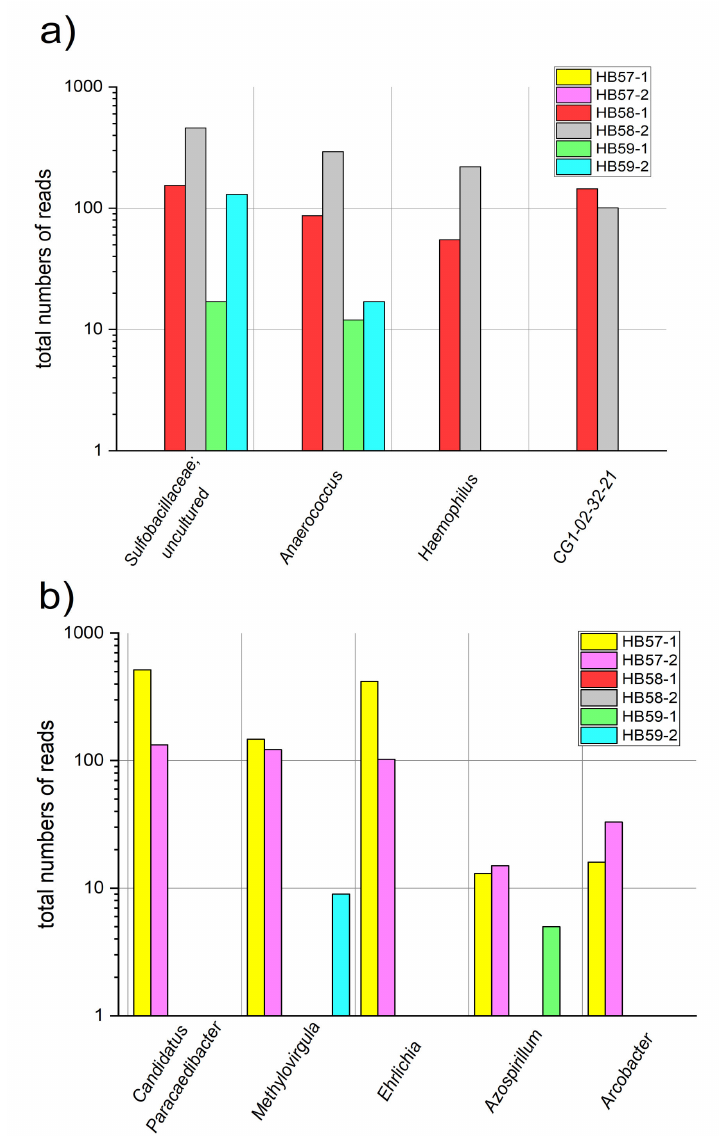
Figure 6. Examples of OTUs (absolute read numbers) distinguishing between the soil types (sampling points): ( a ) OTUs exclusively or preferably found in shaft-filling bright sediment; ( b ) OTUs exclusively or preferably found in the coal